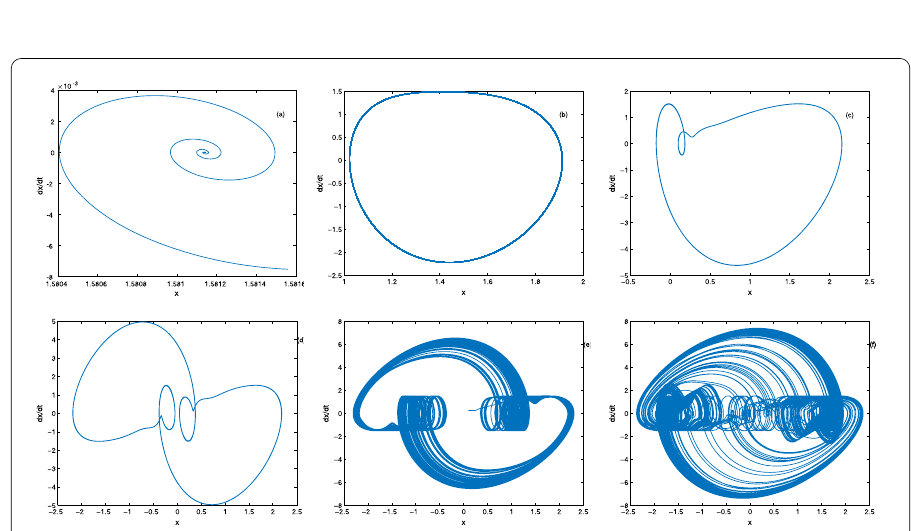
Figure 11 The phase plane plot in x – dx / dt space for different τ : ( a ) τ = 0.2 (stability), ( b ) τ = 0.36 (period-1), ( c ) τ = 0.52 (period-2), ( d ) τ = 0.54 (period-4), ( e ) τ = 0.62 (chaos), ( f ) τ = 0.66 (chaos) with parameter γ = 2.5